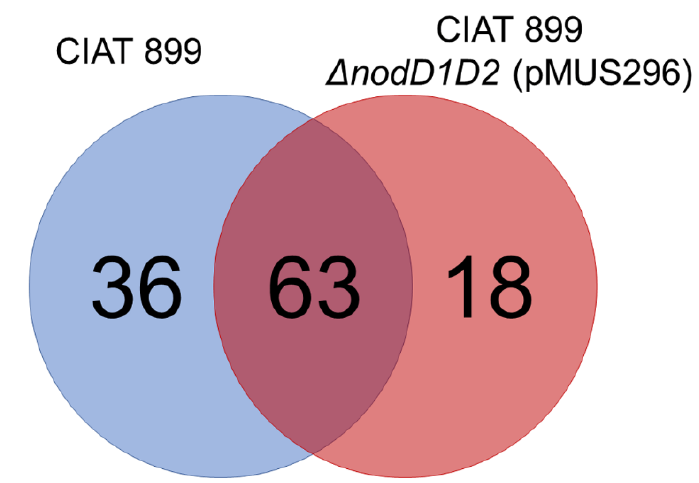
Figure 2. Comparative analysis of the set of Nod factors produced by R. tropici CIAT 899 (blue circle) and CIAT 899 Δ nodD1D2 (pMUS296) (red circle). The differences among these strains are visualized by a Venn diagram.